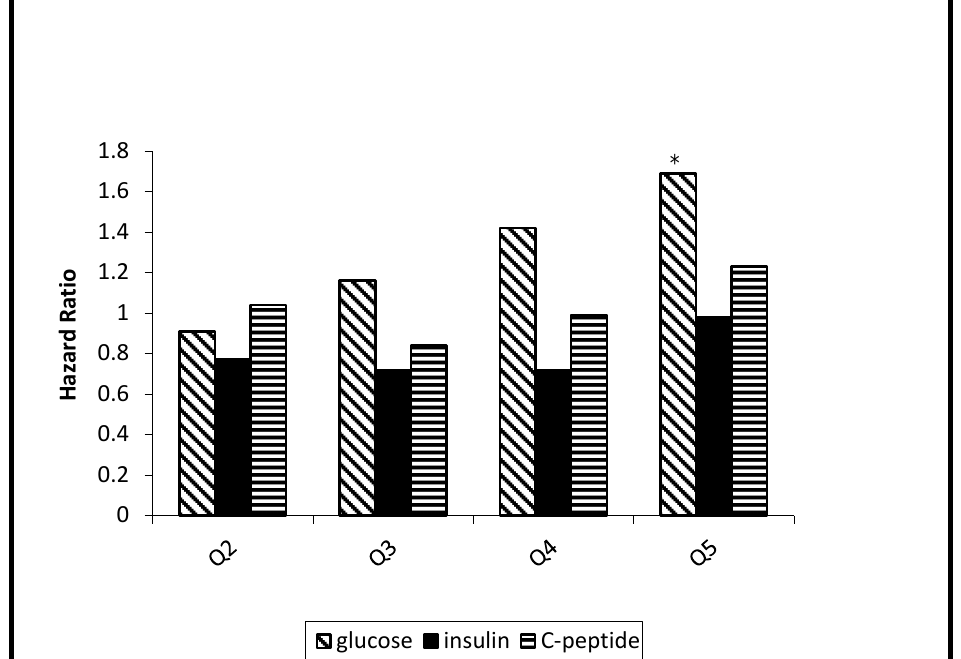
Figure 1. Age-adjusted incidence of CHD by glucose quintiles; trend test p < 0.001.